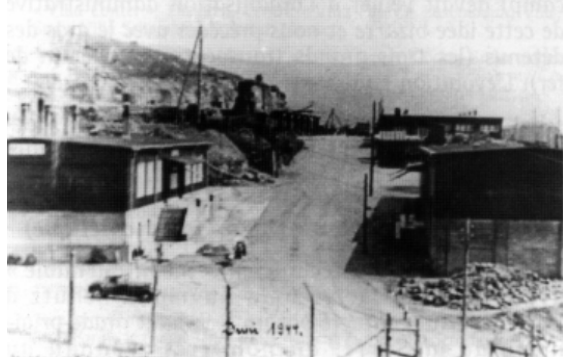
Figure 8 : View of the quarry in June 1944; the forge and depot are the two buildings visible in the foreground